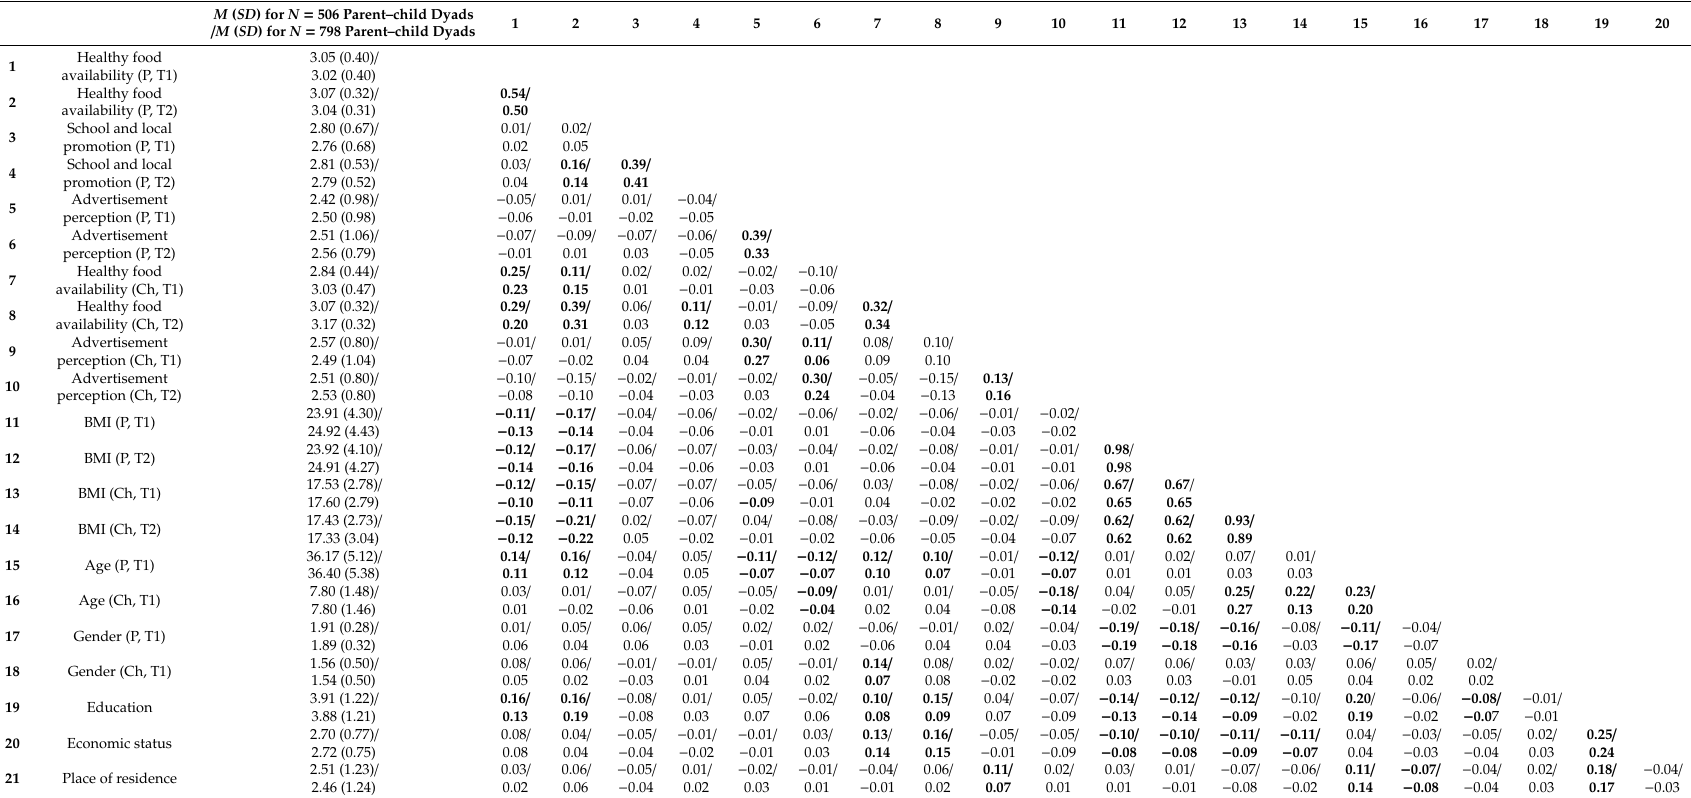
Table A2. Correlations and descriptive statistics for the study variables: Characteristics of the main analyzed sample ( N = 506 parent–child dyads with normal body mass and parent–child dyads with excessive body mass) and for N = 798 (four types of dyads: parent with excessive body mass and child with normal body mass; parent with normal body mass and child with excessive body mass; parent–child dyads with excessive body mass; parent–child dyads with normal body mass). M ( SD )for N = 506Parent–childDyads / M ( SD )for N =